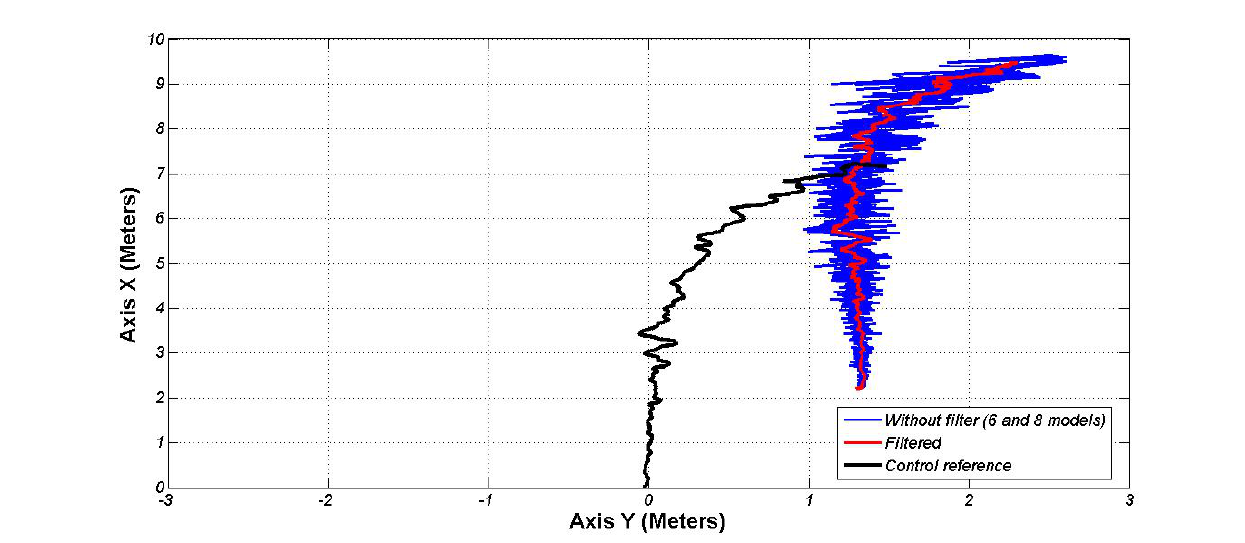
Figure 11. Positions given from the perception system in the final experiment.